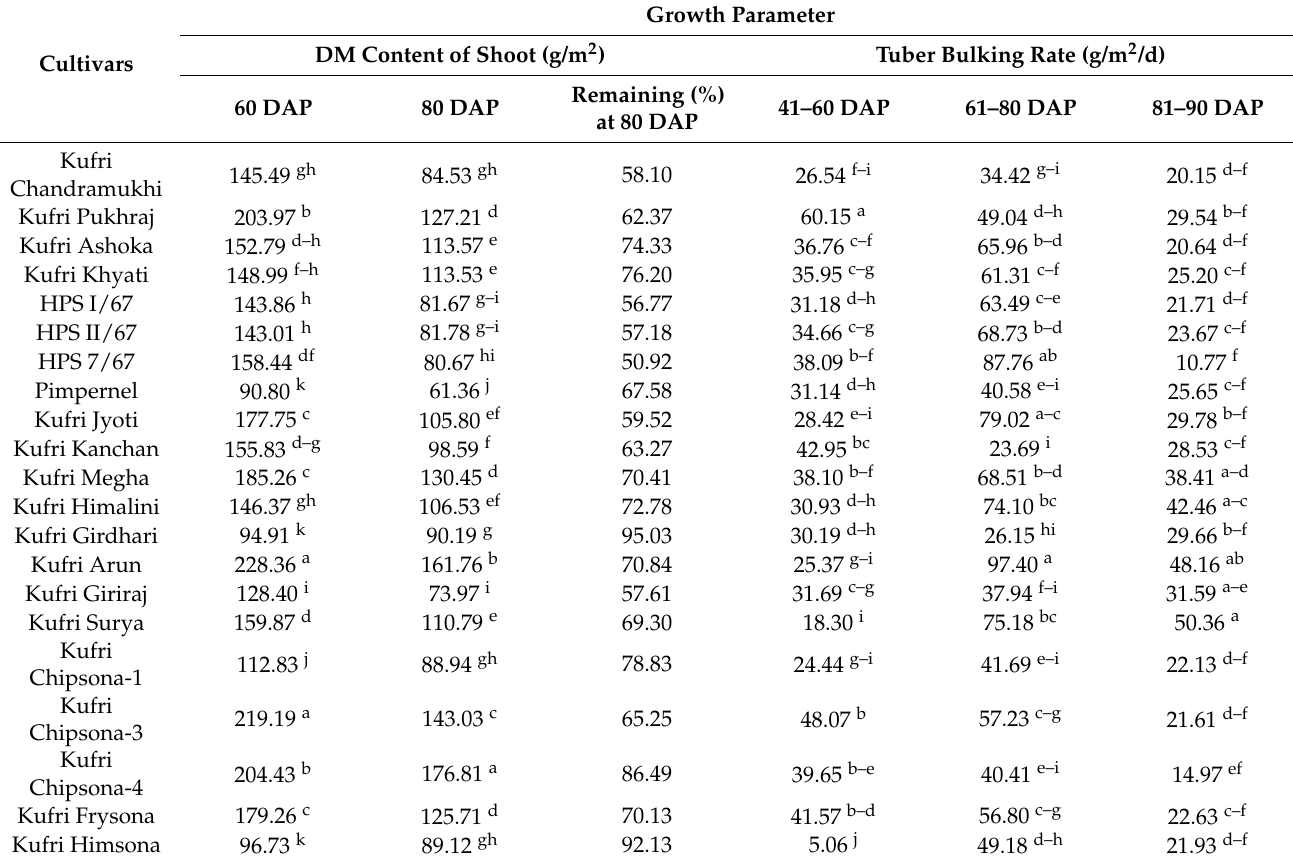
Table 1. Dry matter (DM) content in the shoot and the tuber bulking rate of various potato cultivars (Pooled data of 2 years).